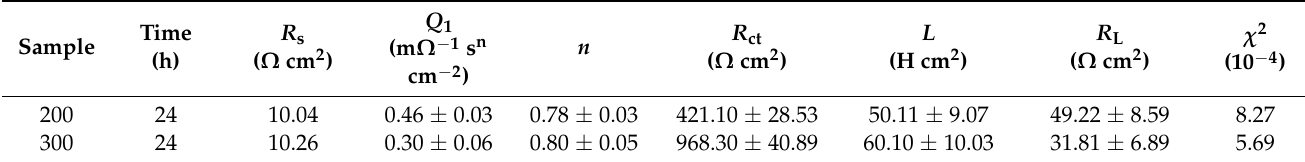
Table 6. Electrochemical impedance parameters of the steels after 24 h of immersion in a 3.5 wt.% NaCl aqueous solution saturated with CO 2 .